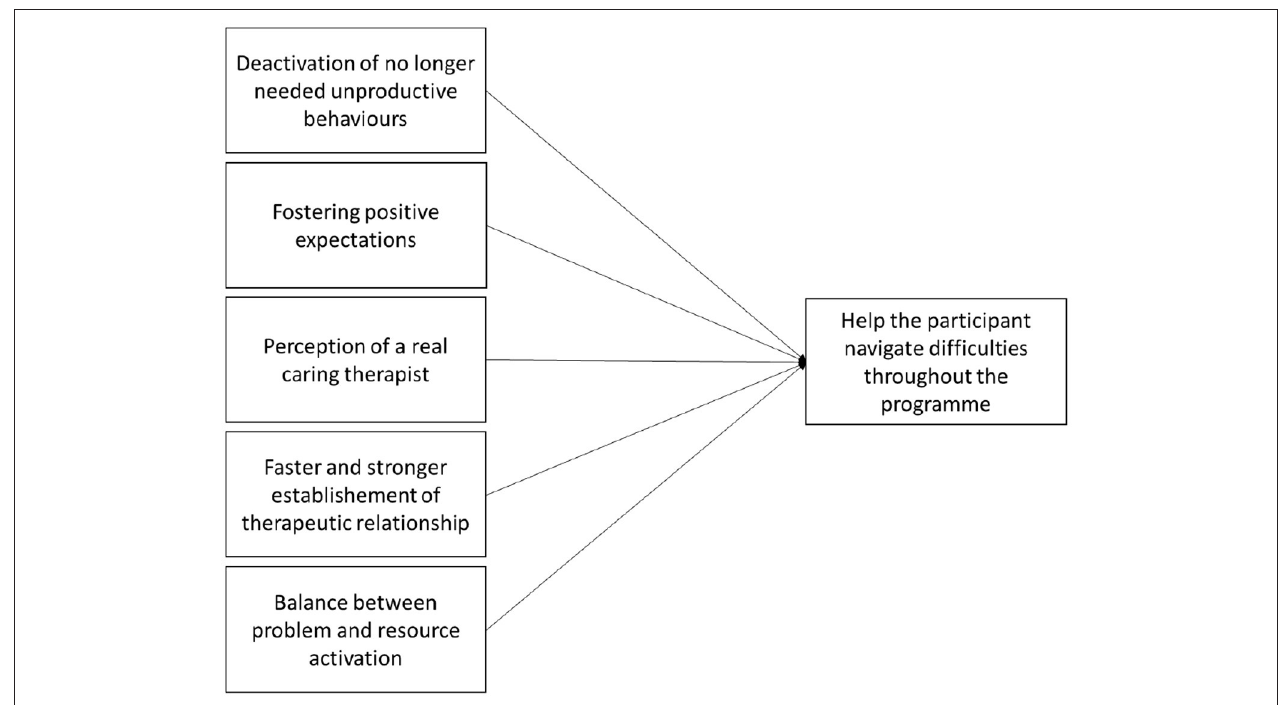
FIGURE 1 | Expected MOTR processes in internet